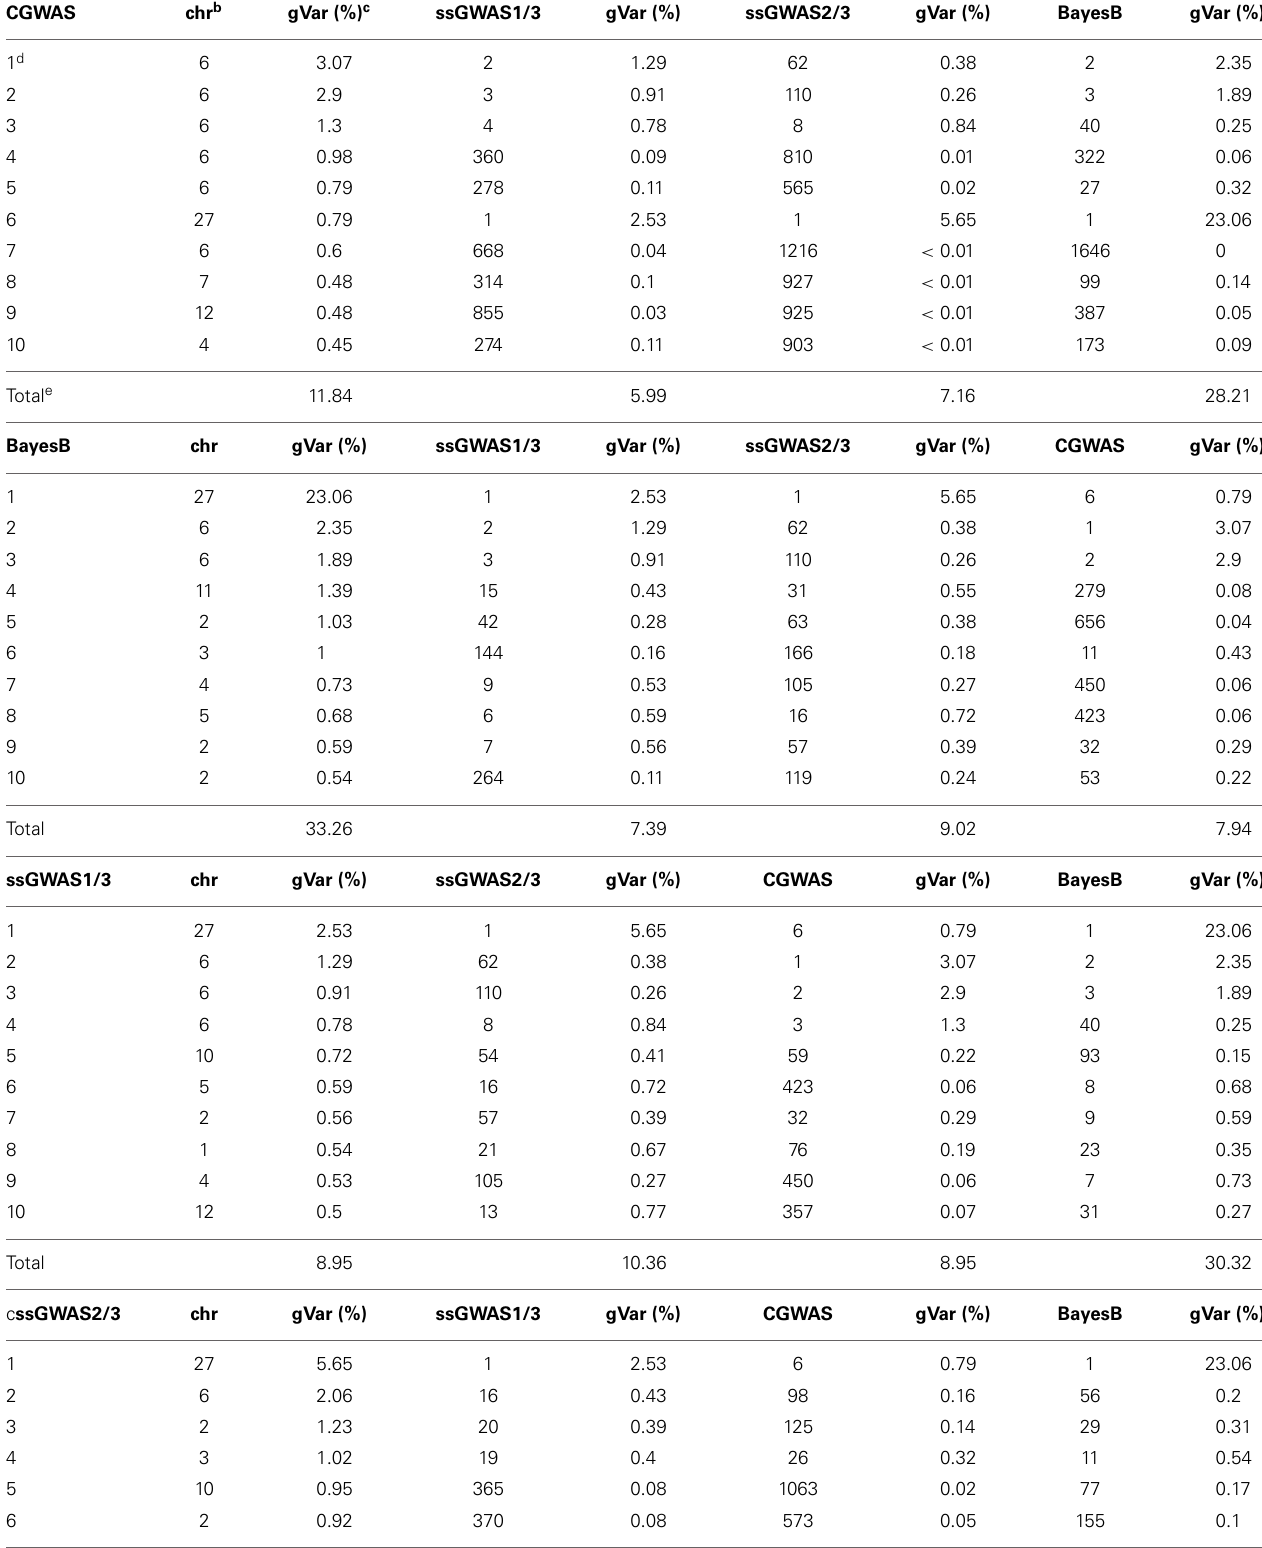
Table 4 | Rankings top 10 regions among different methods a .